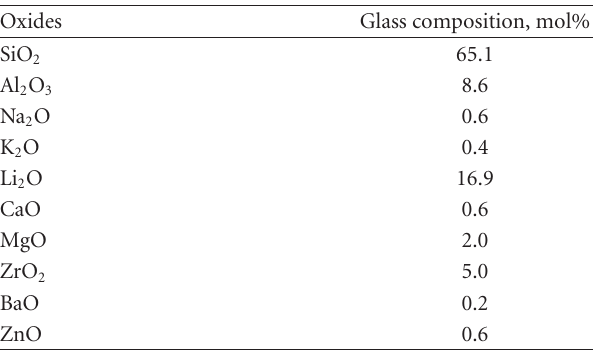
Table 1: Chemical composition of LZSA parent glass.